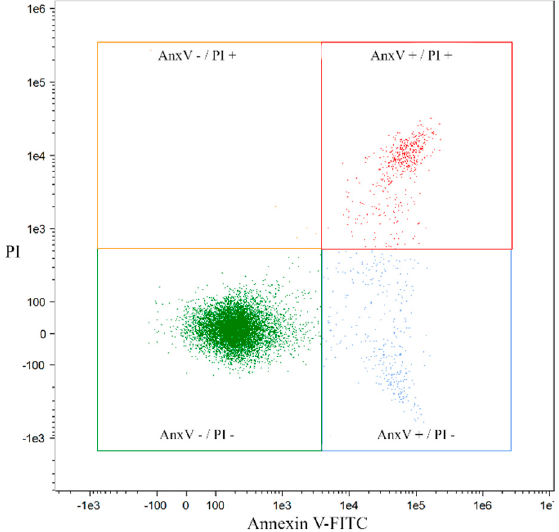
Figure 2. An exemplary “dot plot” of the HL60 / MX1 cell line fraction exposed to bergapten at the IC50 dose in the FlowSight instrument in real time.